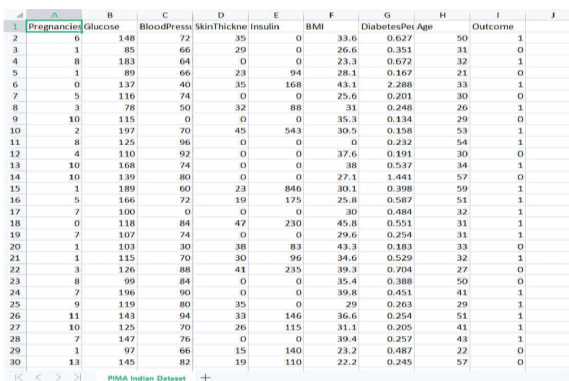
Figure 1: PIMA Indian